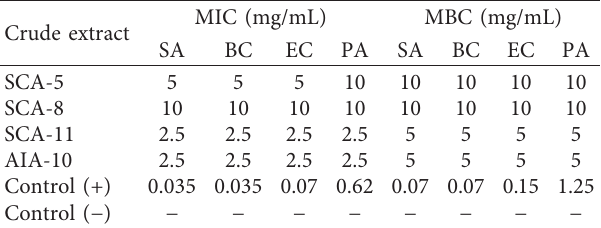
Table 6: MIC and MBC value of the metabolite-crude-extract